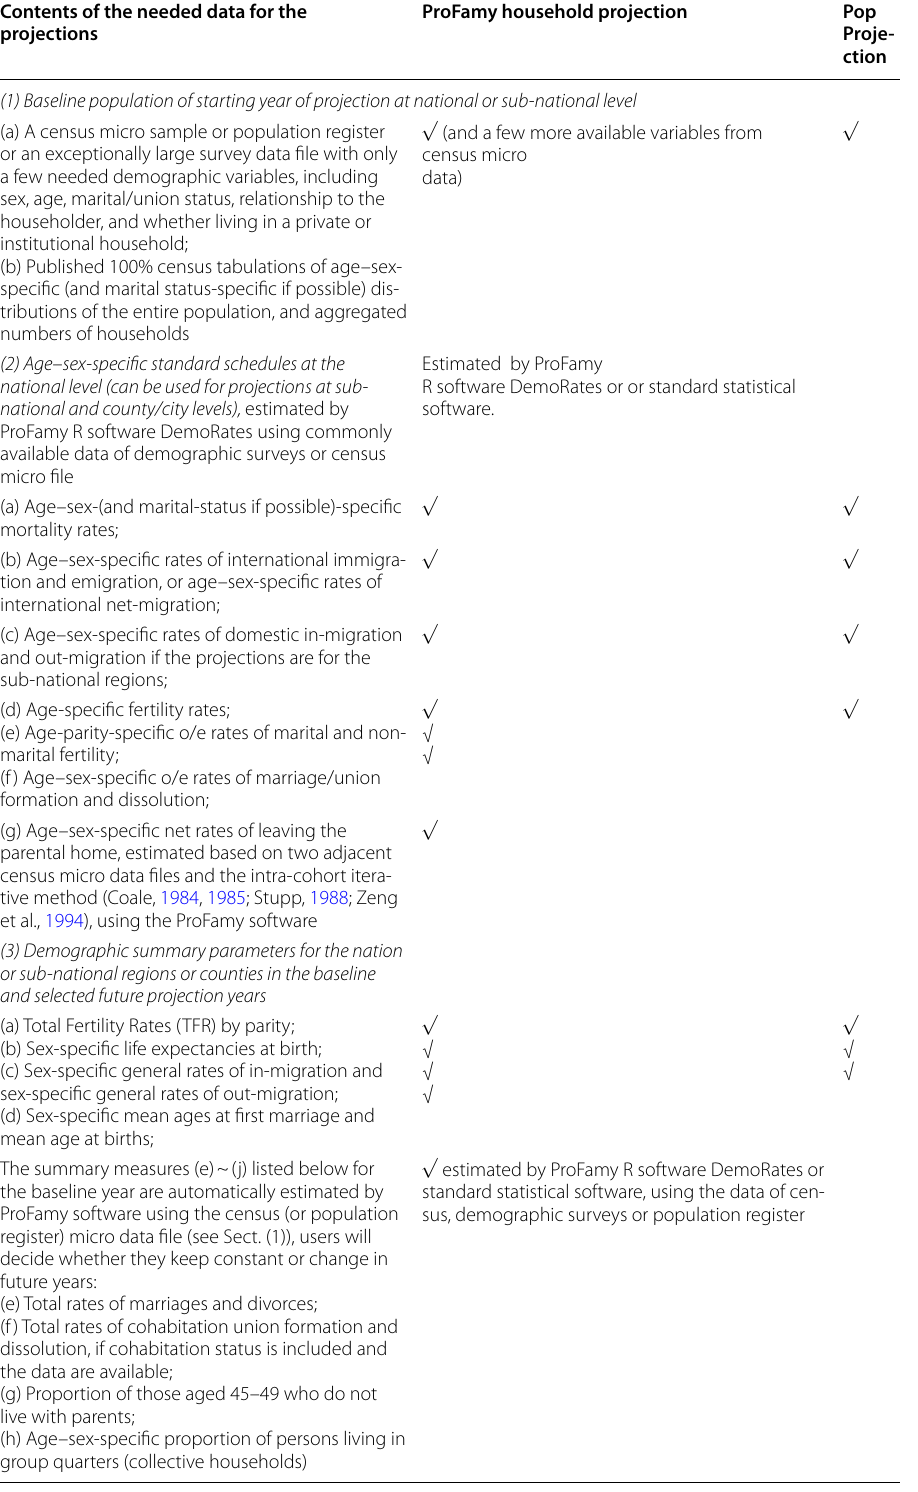
Table 5 Data needs to project households and living arrangements using the ProFamy extended cohort-component method, with a comparison to standard population projections Contents of the needed data for the